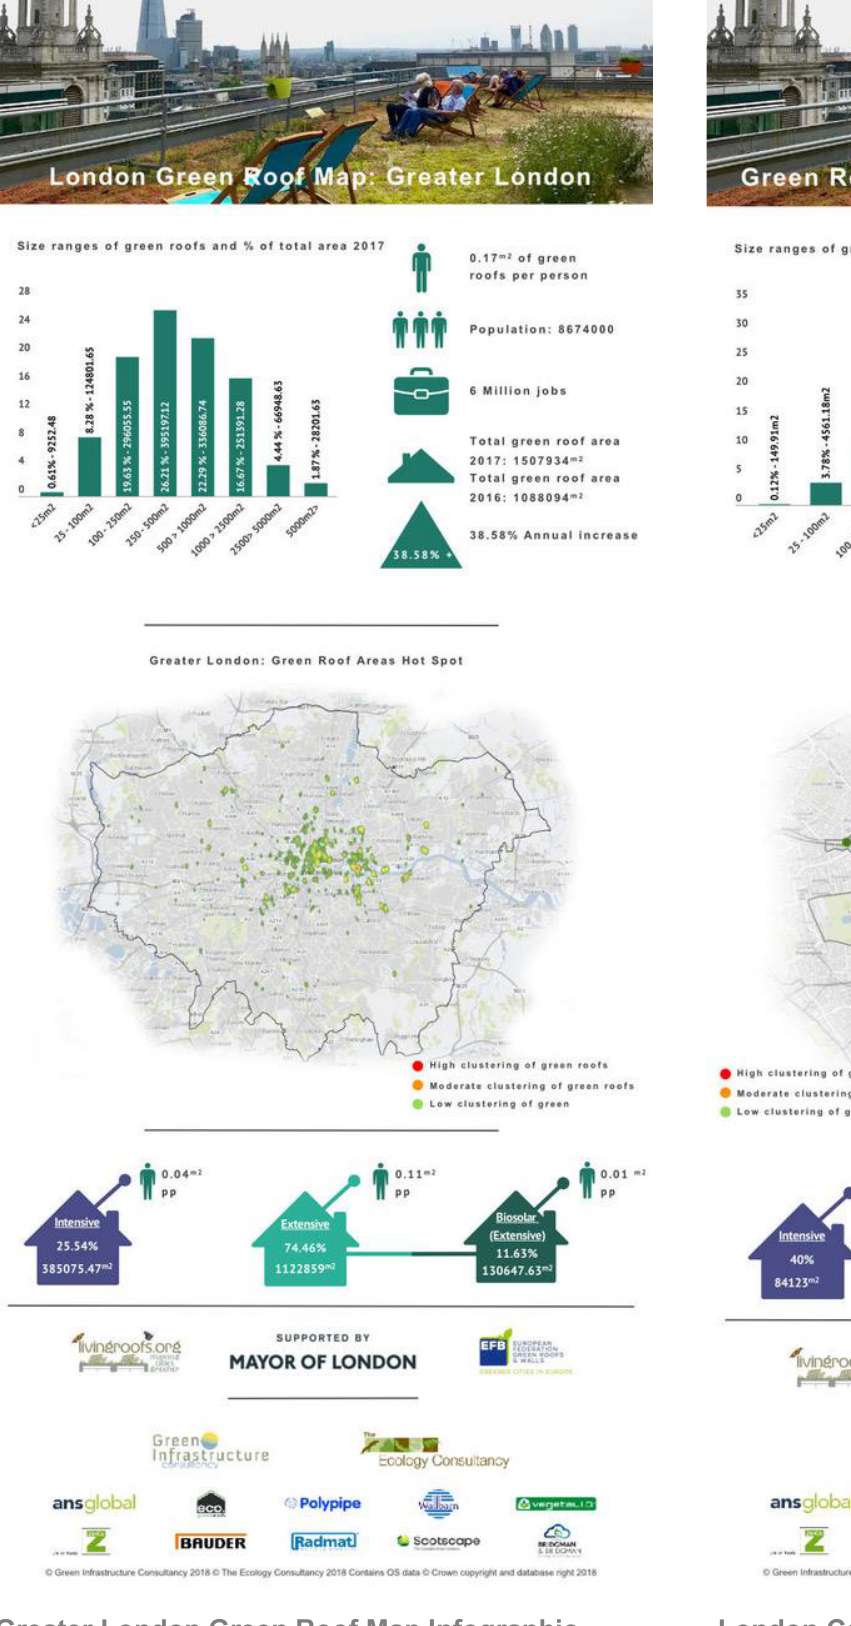
Map Infographic Image: The Green